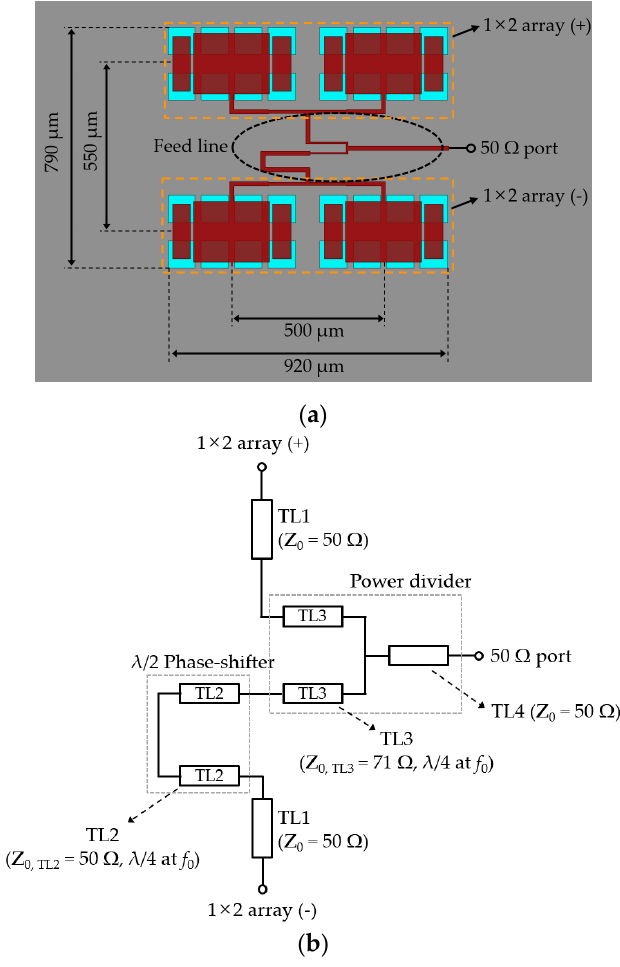
Figure 7. ( a ) Designed 2 × 2 antenna array. ( b ) Feedline structure of 2 × 2 antenna